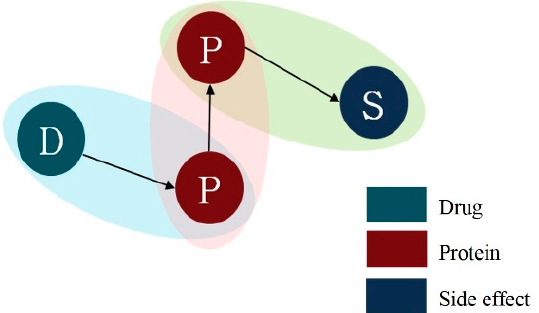
Figure 3. Conceptual model of drug-protein–side effect path. D - drug, P – protein, S – side effect.